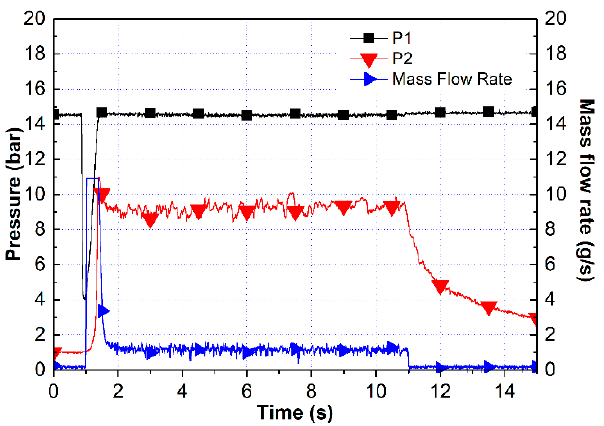
Figure 7. Test result for the 80 wt.% HAN aqueous solution.